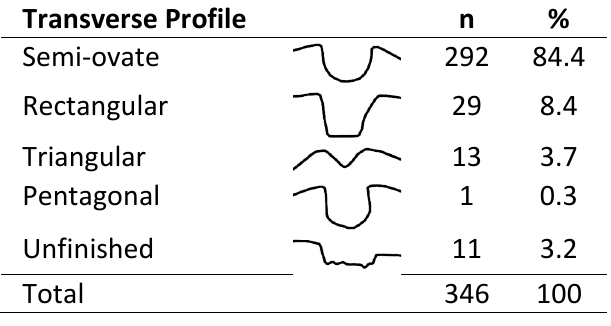
Table 2 The profile of the